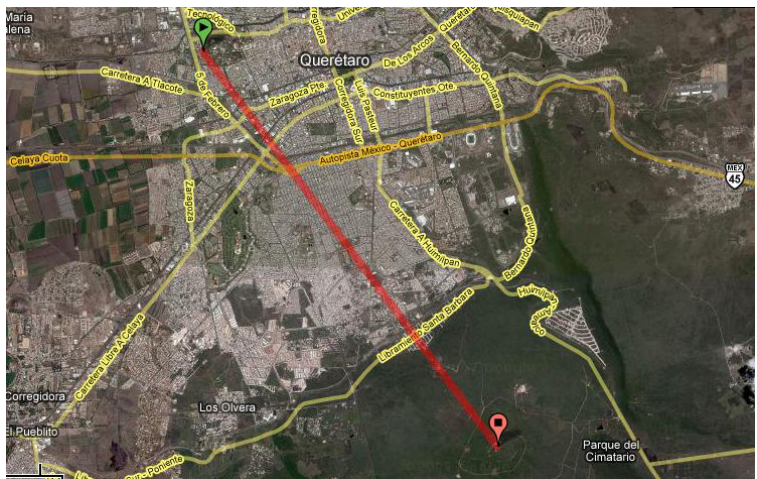
Figure 12. Preliminary field test in the City of Querétaro.